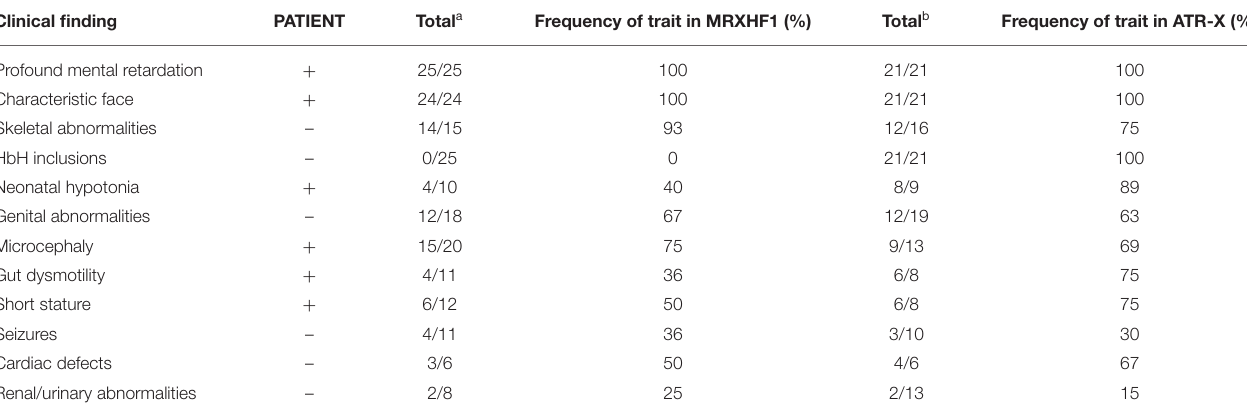
TABLE 3 | Clinical findings in proband, compared with the frequency of pathological traits in MRXHF1 and ATR-X syndrome. Clinical